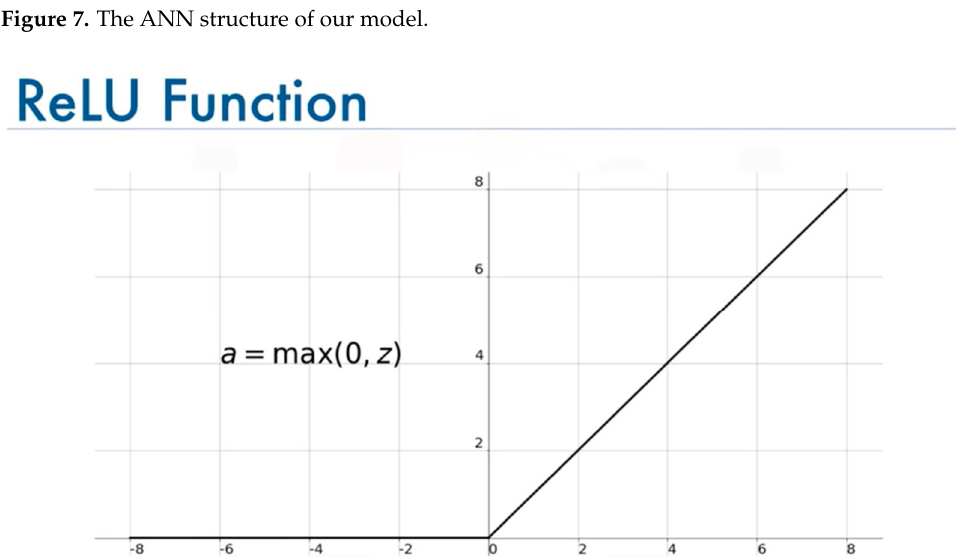
Figure 8. Visual representation of the ReLU activation function.